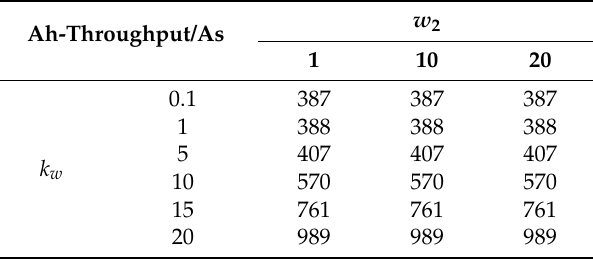
Table 7. LiB Ah-throughput under different k w and w 2.